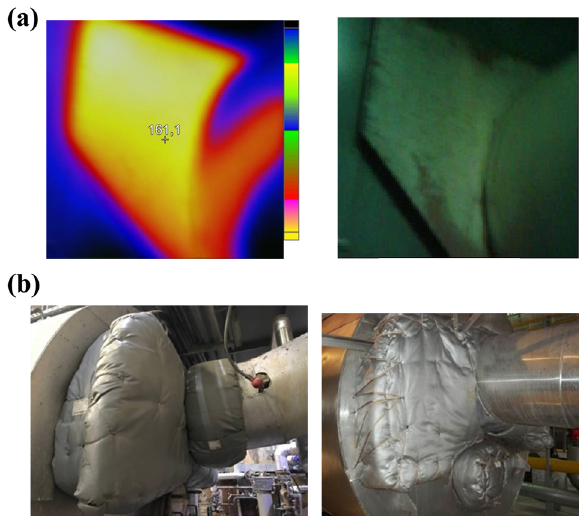
Figure 6: ( a ) Smoke pipe ( 161°C ) and ( b ) recommended insulation jacket and pad for the smoke